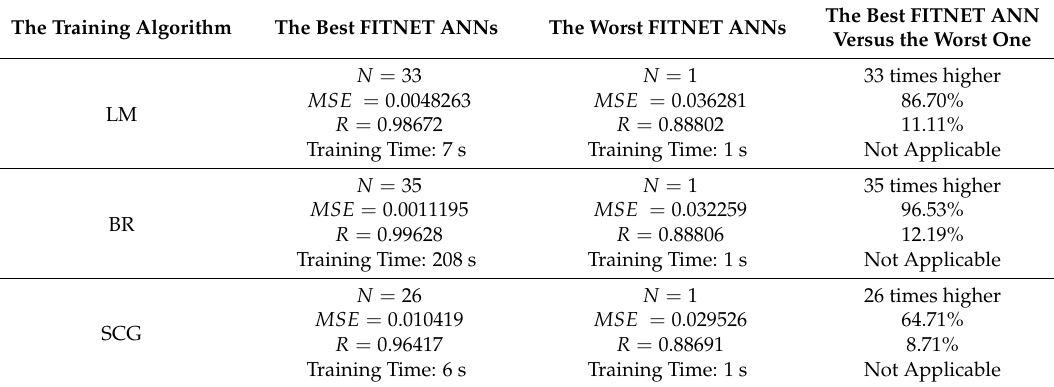
Table 4. The FITNET forecasting ANNs and their corresponding performance